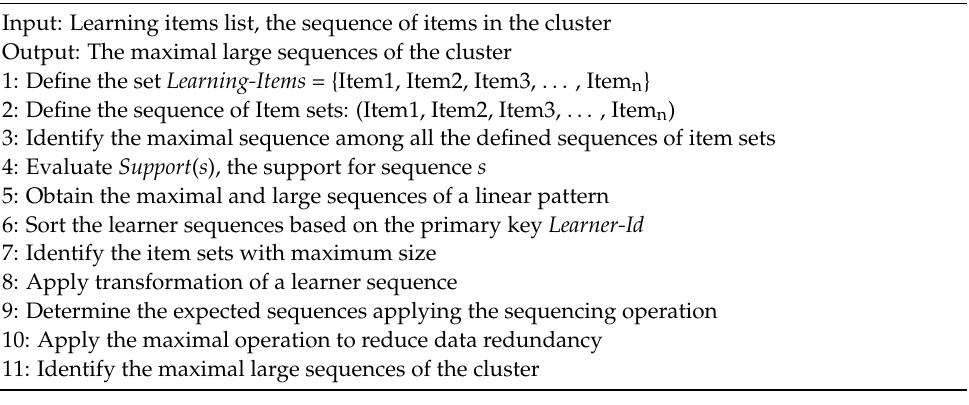
Algorithm 2 Proposed Cluster-Based Linear Pattern Mining